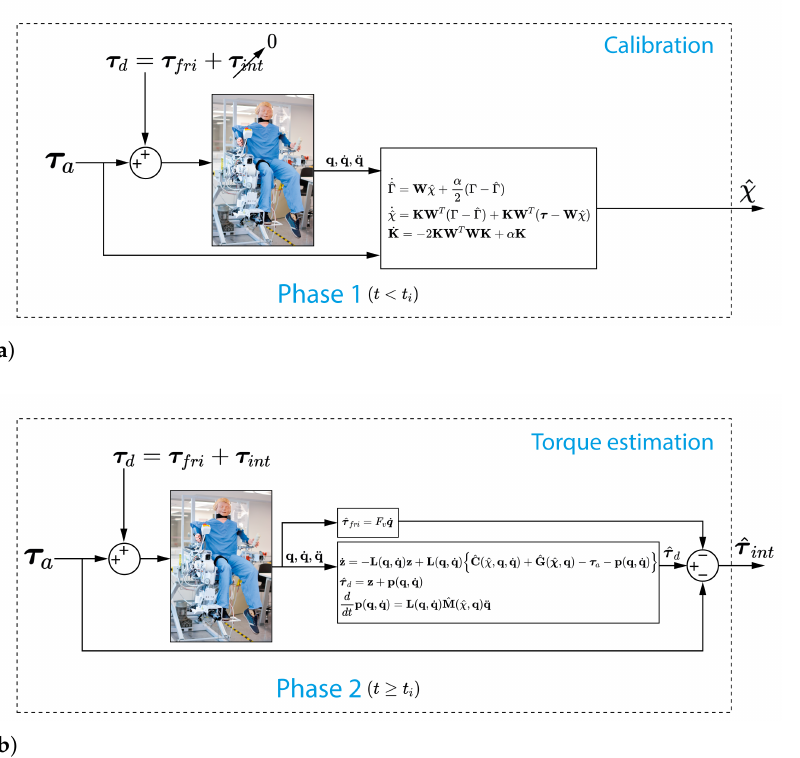
Figure 3. Block diagrams for the INDO. ( a ) Calibration phase and ( b ) torque estimation